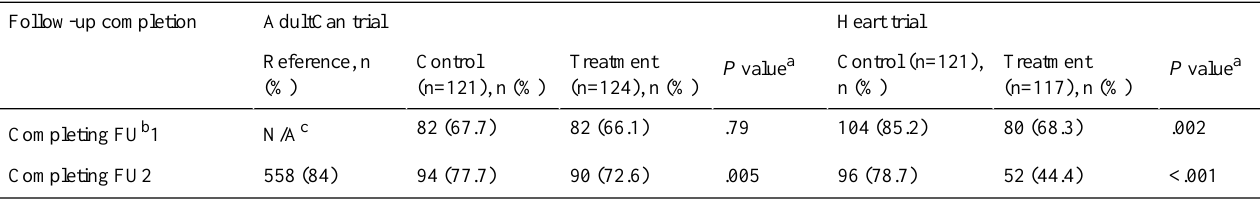
Table 5. Web-based completion rates for the follow-ups for the AdultCan and Heart trials.